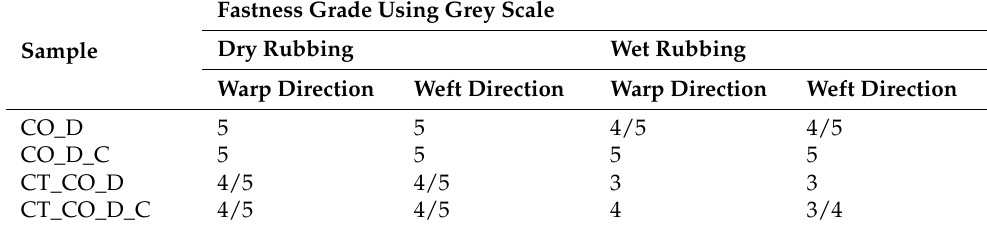
Table 8. Colour fastness to